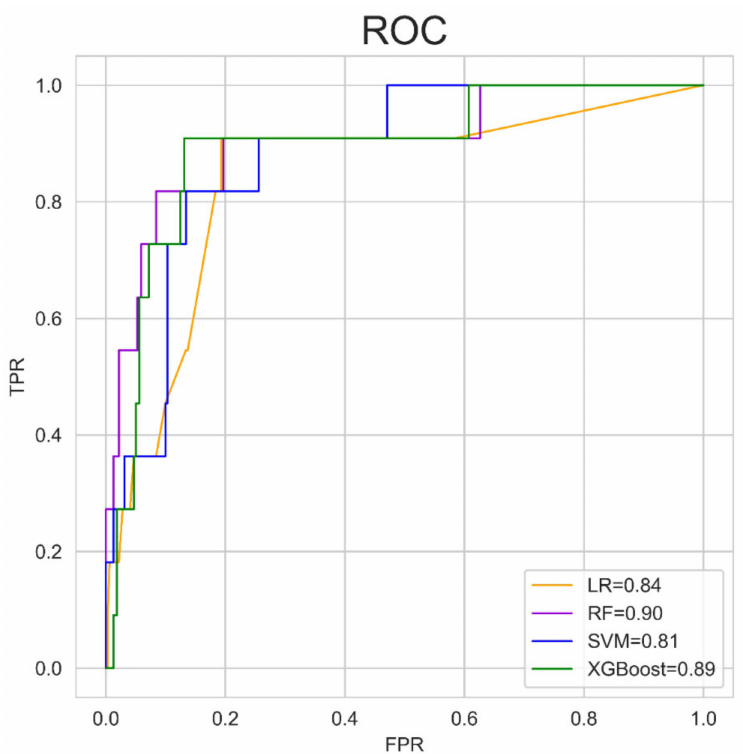
Figure 1. Performance of the machine learning algorithms for predicting AL in the testing set. ROC: receiver operating characteristic curve; LR: logistic regression; RF: random forest; SVM: support vector machine; TPR: true positive rate; FPR, false positive